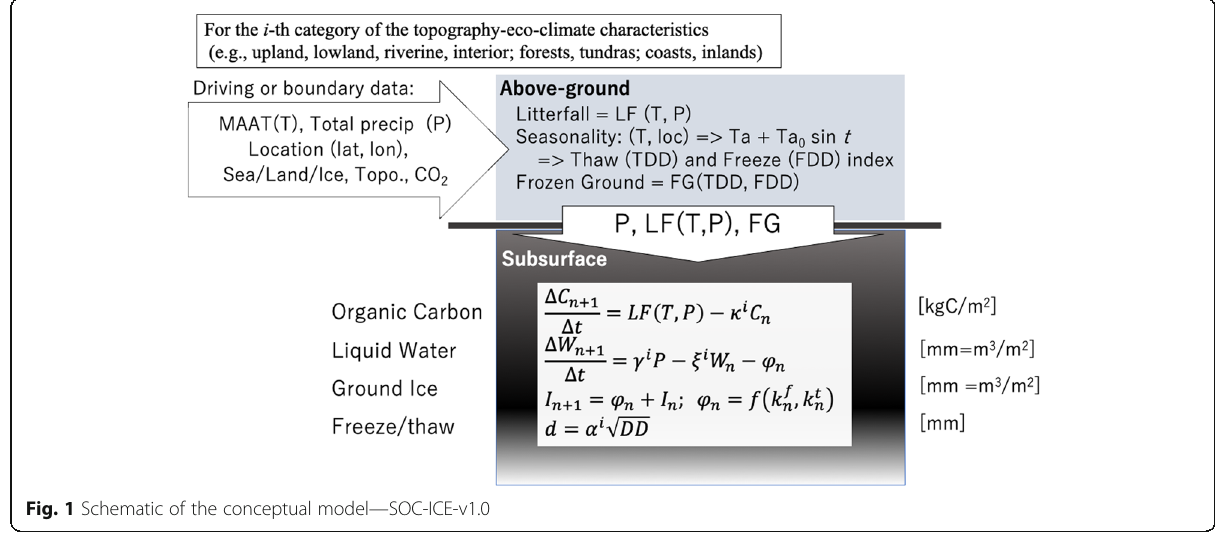
Fig. 1 Schematic of the conceptual model —